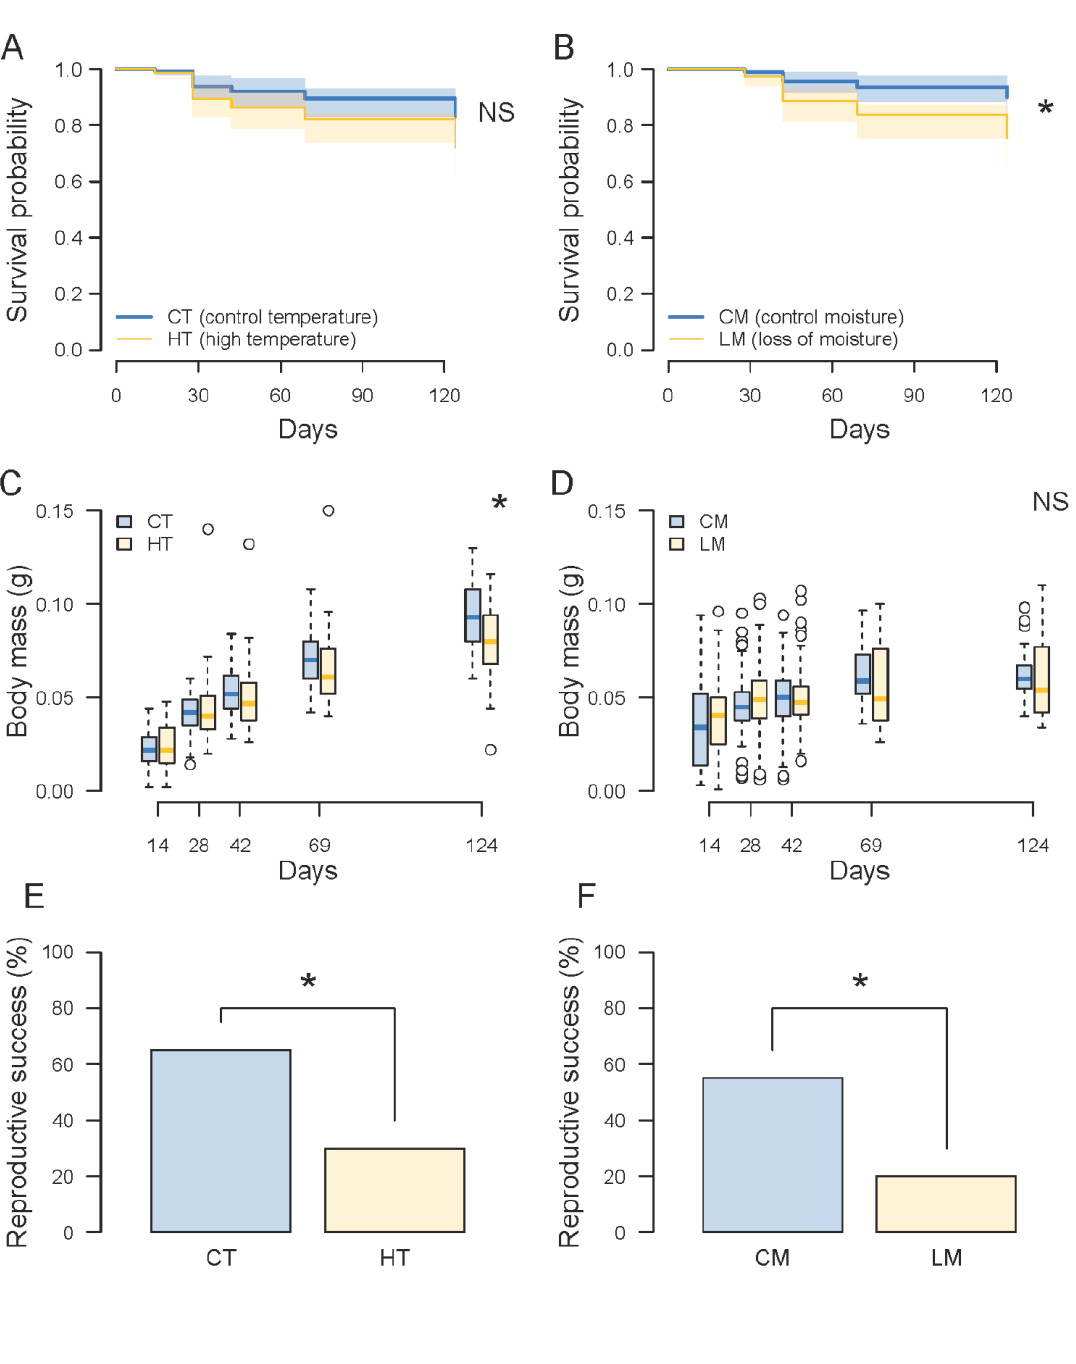
Figure 1 - Effect of the two environmental stressors (Temperature (A, C and E) and Moisture (B, D and F) on Survival (A and B), Body mass (C and D) and Reproductive success (E and F)). Blue colour: control groups, orange colour: stress groups. CT: Control Temperature (20°C), HT: High Temperature (28°C), CM: Control Moisture (80%), LM: Loss of Moisture (50%). NS: No significant; * P<0.05. Physiological traits Immune cells Immune cell viability was not affected by the thermal stress (F 1,56 =0.92, P=0.34, standardized slope  = -0.25; 95%CI=[-0.79;0.27], Fig. 2A, Supp. File2 Table S2g and Supp. File3-2.A.1) but decreased during the water stress (F 1,50 =4.17, P=0.046, standardized slope  =0.55; 95%CI=[0.01;1.09], Fig. 2B, Supp. File2 Table S2h and Supp.